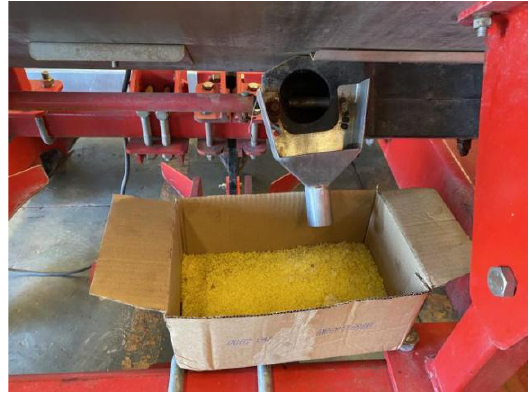
Figure 8. Fertilizer discharge measurement test.